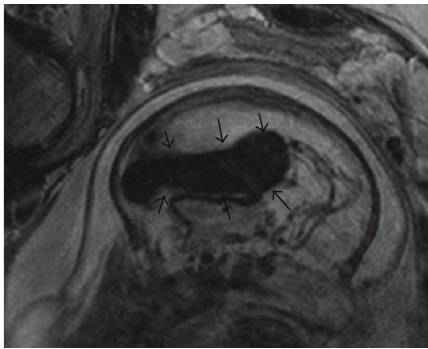
Figure 2: Fetal MRI imaging of aneurysm of vein of